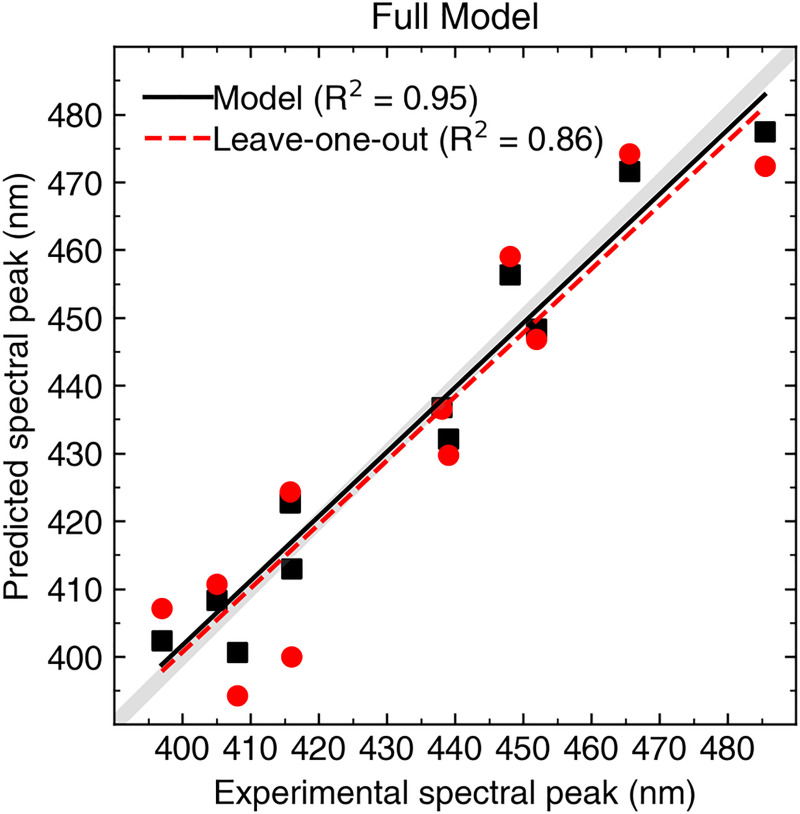
Experimental spectral peaks of absorbance (λmax) compared to predicted λmax values by the full model Eq 1 outlined in the main text for all 11 Sws2 photopigments analyzed.Gray lines indicate a perfect (100%) correlation. Solid black lines and black symbols represent the linear relationships between model-predicted and the experimental λmax values, whereas dashed red lines and red symbols show linear relationships between “leave-one-out” predictions and experimental λmax values. Corresponding correlation coefficients for both approaches are indicated.